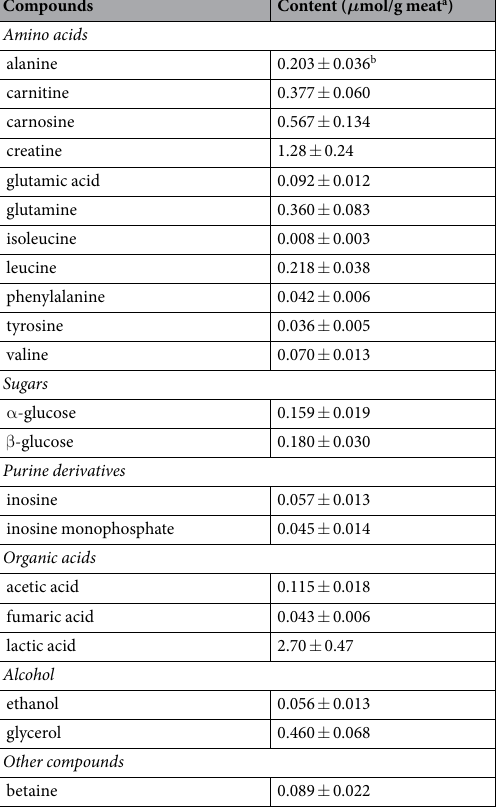
fat of sirloin using GC-FID and compared the total ratio of unsaturated fatty acids with the NMR-detected N C = C value. The ratio of each fatty acid was summarized as a weight percent in Table 2. Oleic acid (C18:1, cis -9) showed the highest ratio ( > 50 wt%) among the observed fatty acids. The ratios of other fatty acids decreased in the fol- lowing order: palmitic acid (C16:0) > stearic acid (C18:0) > palmitoleic acid (C16:1, cis -9) > linoleic acid (C18:2, cis -9,12) > myristic acid (C14:0) > myristoleic acid (C14:1, cis -9). However, palmitoleic acid (C16:1, cis -9) was found at a higher content than stearic acid (C18:0) only in the sirloin samples of brand A, which may be the cause of the higher N C = C value of brand A. The total ratio of unsaturated fatty acids ranged from 60.2 wt% to 73.1 wt%, which was calculated by summation of the ratio of myristoleic acid (C14:1, cis -9), palmitoleic acid (C16:1, cis -9), oleic acid (C18:1, cis -9), and linoleic acid (C18:2, cis -9,12). The NMR-detected N C = C values were plotted against the total ratio of unsaturated fatty acids (Fig. 3A), which showed a good correlation between these two evaluated values ( R 2 = 0.944). The results suggest that the total ratio of unsaturated fatty acids, which attribute to the tender-